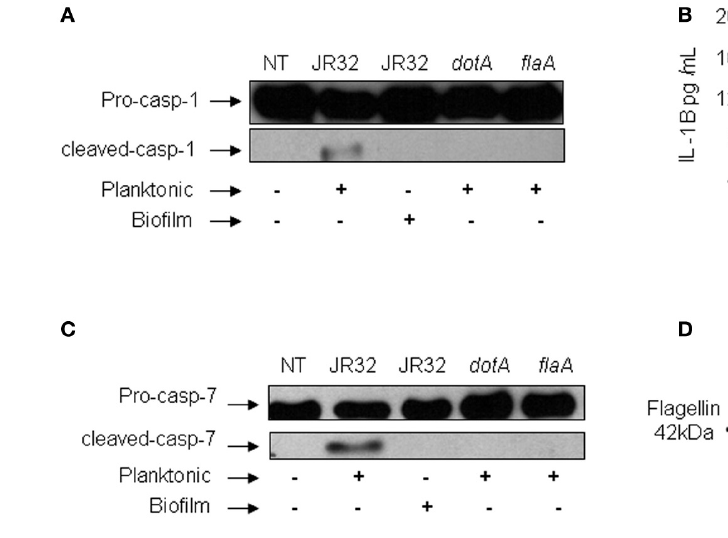
FIGURE 3 | Biofilm-derived L. pneumophila did not promote caspase-1 or 7 activation in murine macrophages and showed significantly less IL-1 β release due to lack of flagellin expression. (A) Pro and active caspase-1 were detected in cell extracts using caspase-1 antibody. WT BMDMs were either not treated (NT) or infected with L. pneumophila JR32 (biofilm or planktonic), the dotA or the flaA mutant for 2h. (B) The amount of